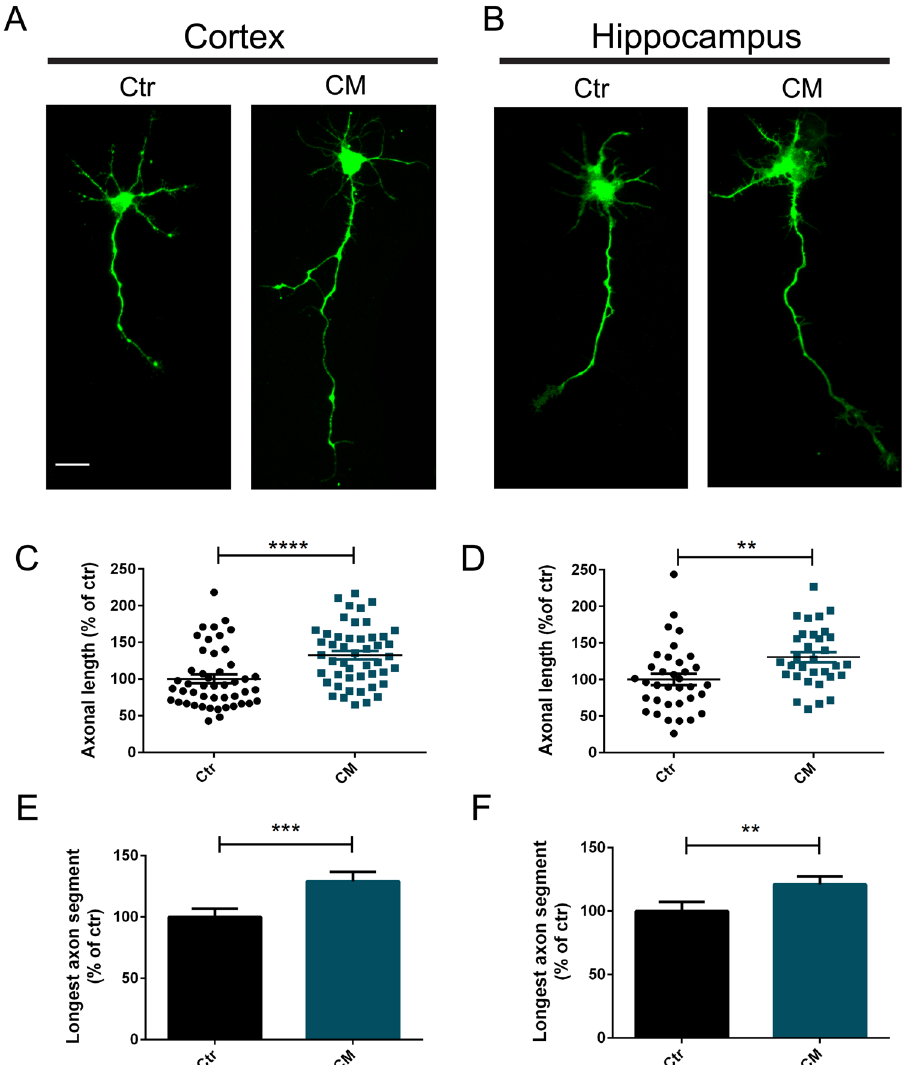
Figure 1. HUCPVC Conditioned Media (CM) induces axonal growth in CNS neurons. ( A , B ) Effect of CM in axonal outgrowth on cortical and hippocampal neurons. At DIV3 neurons were stimulated for 14 hours with CM. Axonal outgrowth was assessed by immunocytochemistry using an antibody against Tau, an axonal specific marker. Images were taken from random neurons using an AxioObserver Z1 fluorescent microscope with a PlanApochromat 20 × objective. ( C – F ) Quantification of axonal length and axonal longest segment. Results show that axonal network increase after 14 h of CM stimulation ( C , D ), and in addition neurons stimulated with CM have the longest axonal segments ( E , F ), demonstrating that global application of CM to both hippocampal and cortical neurons induce an increase in axonal outgrowth. Axonal length and longest axonal segments analysis was performed with Image J 1.45e software. Bars and plots represent the mean ± SEM of approximately 45 neurons randomly selected of 3 independent experiments. ( C ) **** Represents p < 0.0001; ( D ) * Represents p = 0.0025; ( E ) *** Represents p = 0.0010; ( F ) * Represents p = 0.0083 by Mann Whitney unpaired t-test when compared to Ctr. The scale bar is 25 µ